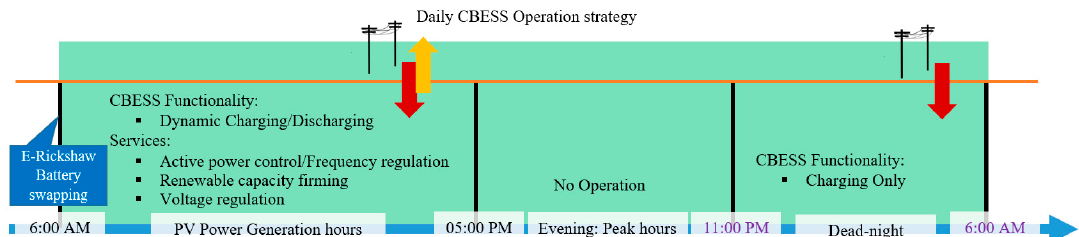
Figure 11. Time-based daily operational strategy of CBESS. Batteries are charged mainly during the day at the same time it provides grid services.